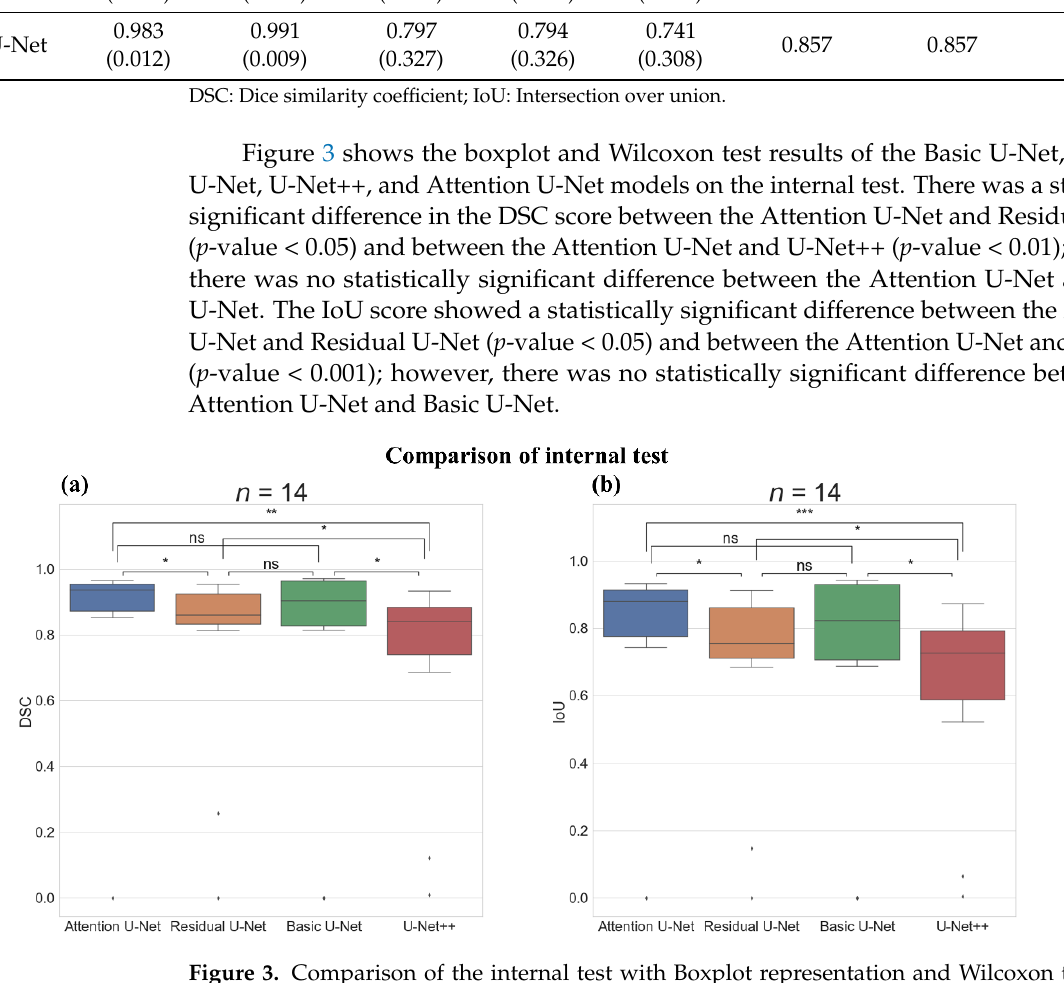
Figure 3. Comparison of the internal test with Boxplot representation and Wilcoxon test results between the deep-learning algorithms. ( a ) Boxplot representation and Wilcoxon test results of dice similarity score (DSC) and ( b ) Boxplot representation, and Wilcoxon test results of intersection over union score (IoU). ns: not significant, *: p -value < 0.05, **: p -value < 0.01, ***: p -value < 0.001, Number of images ( n ) = 14.